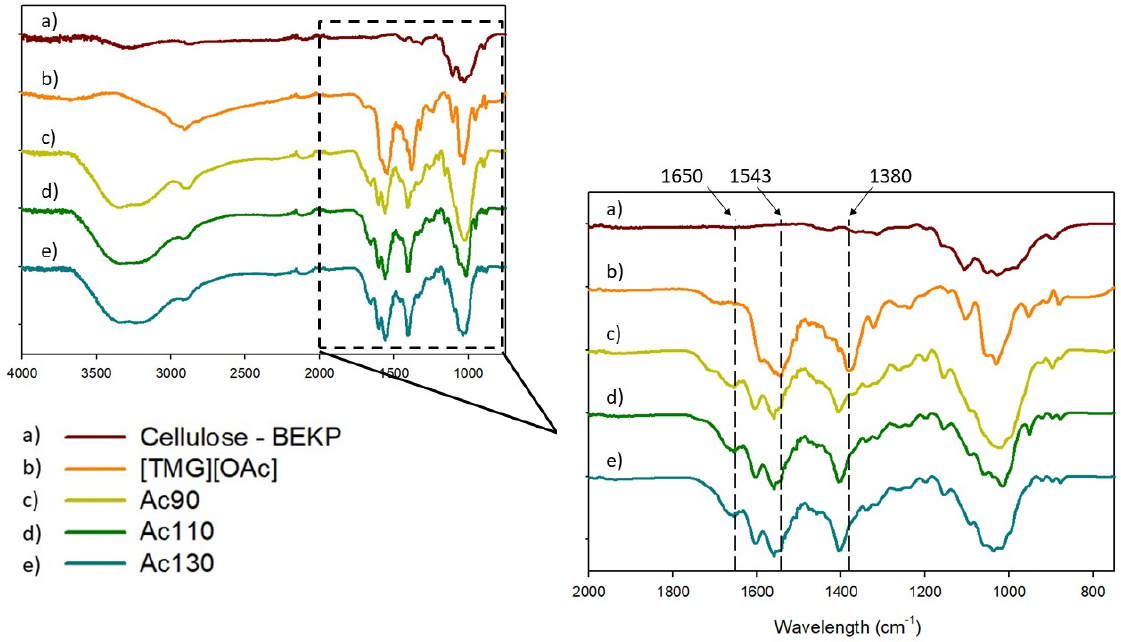
Figure 2. FT-IR spectrum of ( a ) BEKP, ( b ) [TMG][OAc], and films ( c ) Ac90, ( d ) Ac110, ( e ) Ac130.